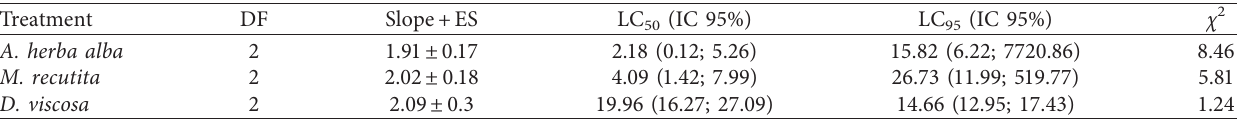
Table 4: LC50 and LC95 values ( μ L/1litre of air) calculated based on the mortality of C. maculatus adults after 24 h exposure to various concentrations of essential oils in the inhalation test.